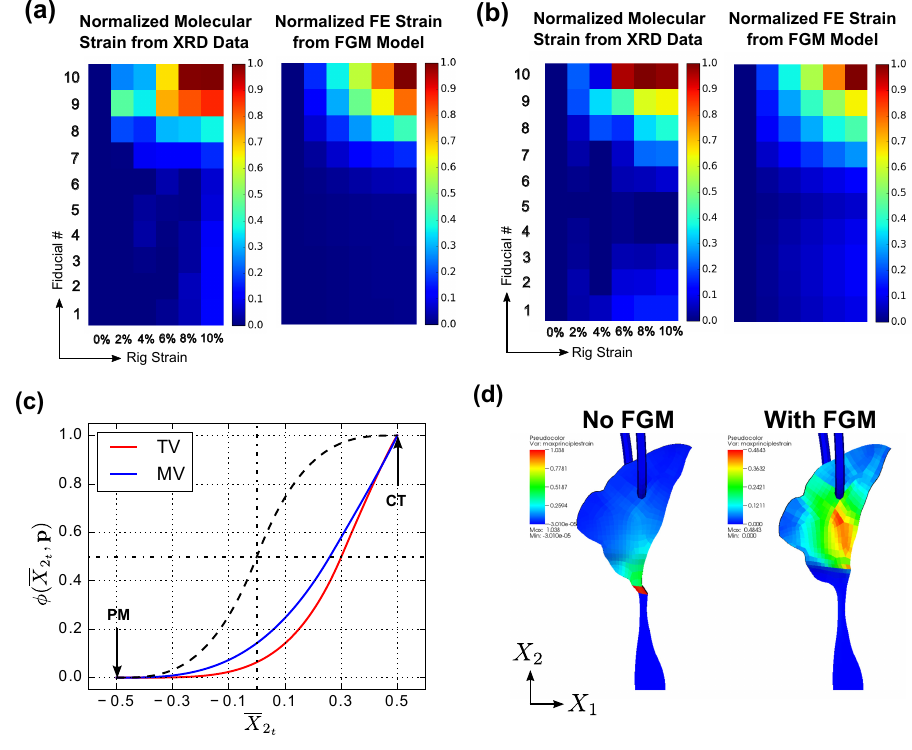
Figure 9. Colormaps indicating normalized strain distribution from XRD and inverse FE in the CT–PM transition regions for ( a ) TV and ( b ) MV specimens. ( c ) Optimized constituent distribution function φ ( X 2 , p ) with (cid:98) p = ( 0.301,1.084 ) and (cid:98) p = ( 0.26,0.945 ) for the TV and MV specimens, respectively. t Additionally, overlaid in ( c ) is a symmetric sigmoid for purposes of comparison. ( d ) Strain